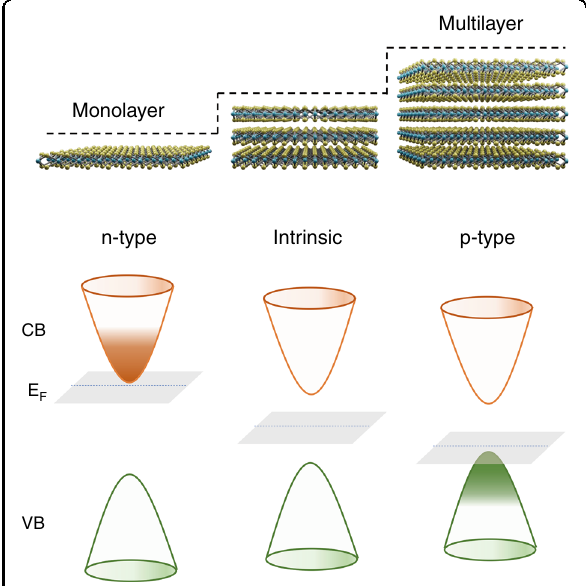
Fig. 1 Schematically showing the thickness dependent doping characteristic of layered